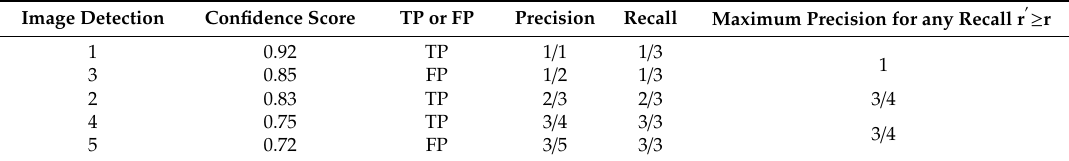
Table 3. Ranked detection results of one category according to the confidence score.